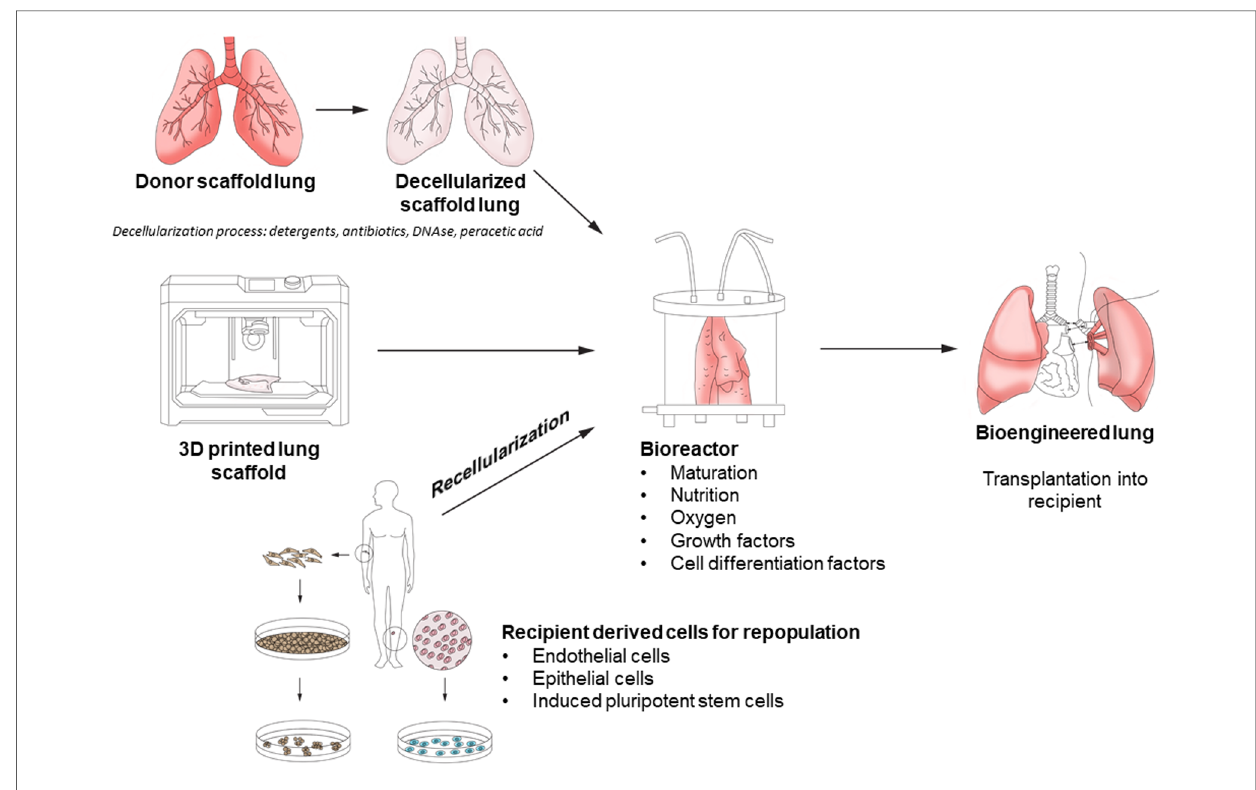
FIGURE 1 Overview of lung bioengineering